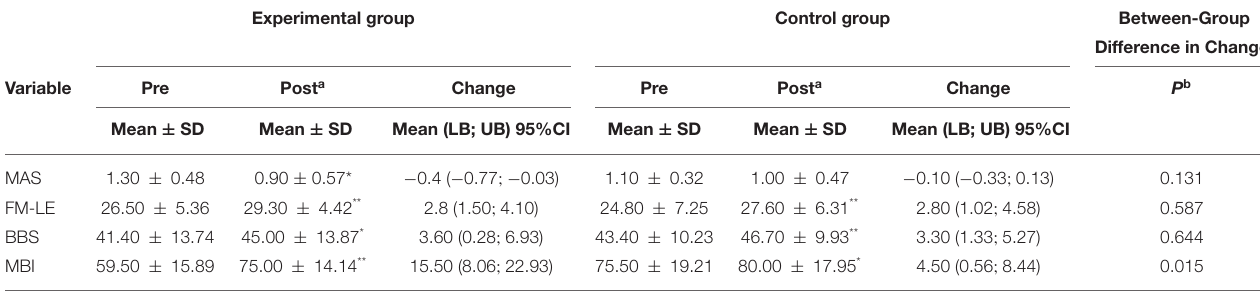
TABLE 3 | Clinical evaluations at pre- and post-training between two groups. Experimental group Control group Between-Group